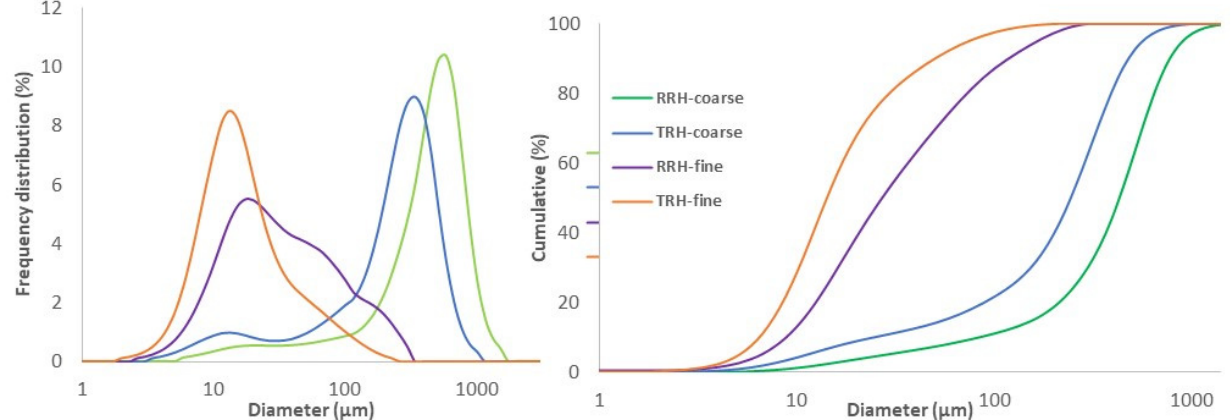
Figure 1. Particle size distribution for raw rice hulls (RRH) and torrefied rice hulls (TRH) shown by frequency distribution ( left ) and cumulative percentage ( right ).